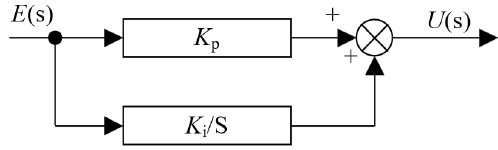
Figure 15. Block diagram of PID